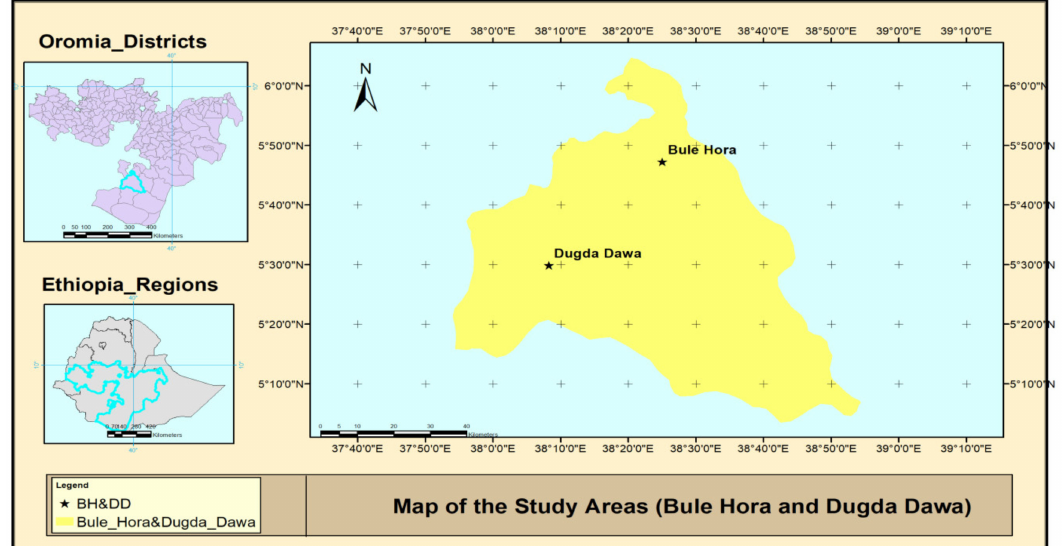
Figure 1. A map showing the locations of the study areas: the Hule Hora and Dugda Dawa districts of the West Guji Zone, Oromia State,